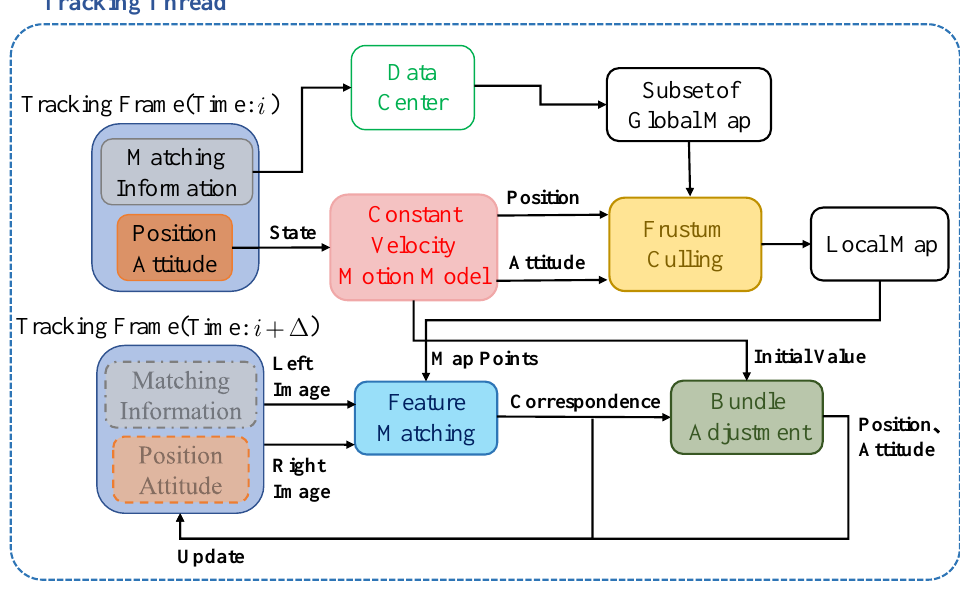
Figure 5. Flowchart of tracking thread.